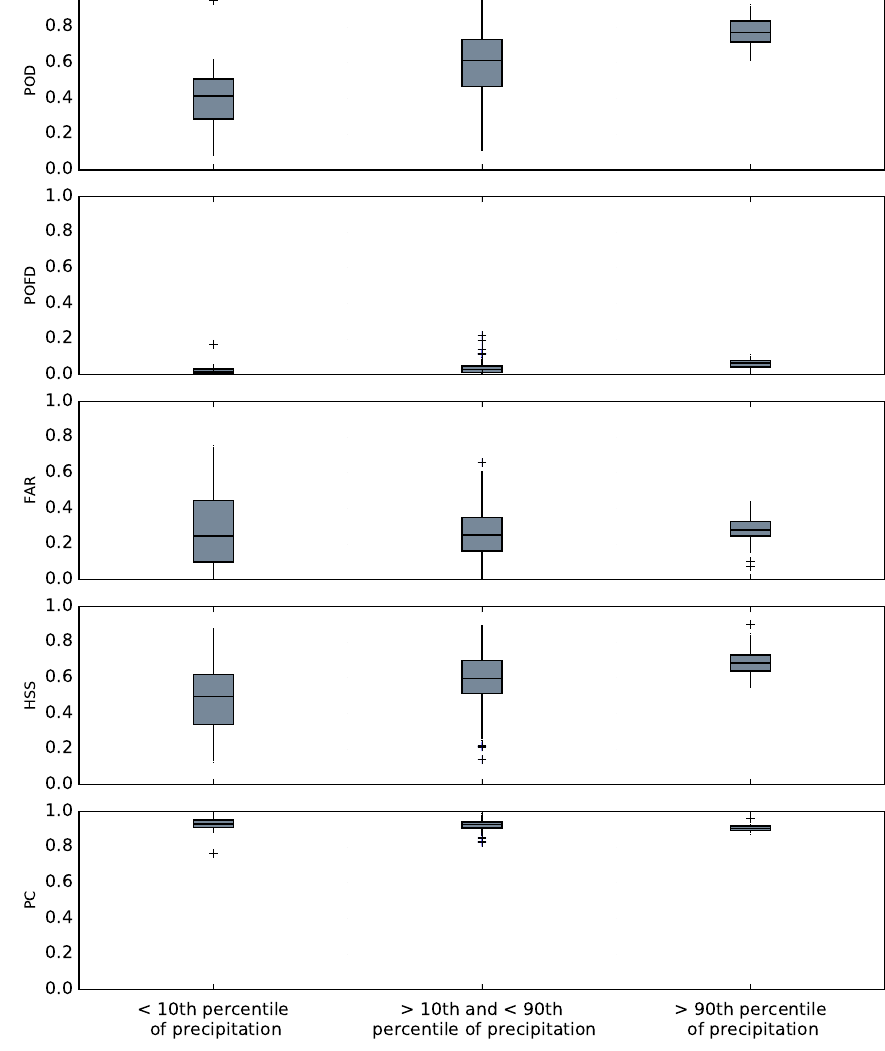
Figure 7. Performance of the new precipitation area delineation for July 2017 as boxplots for low, medium and high precipitation amounts according to percentiles. The boxes display the 25th, 50th and 75th percentiles. Whiskers indicate extreme data up to 1.5 times of the interquartile range. Outliers are marked as crosses. The width of the boxes is relative to the available number of validation